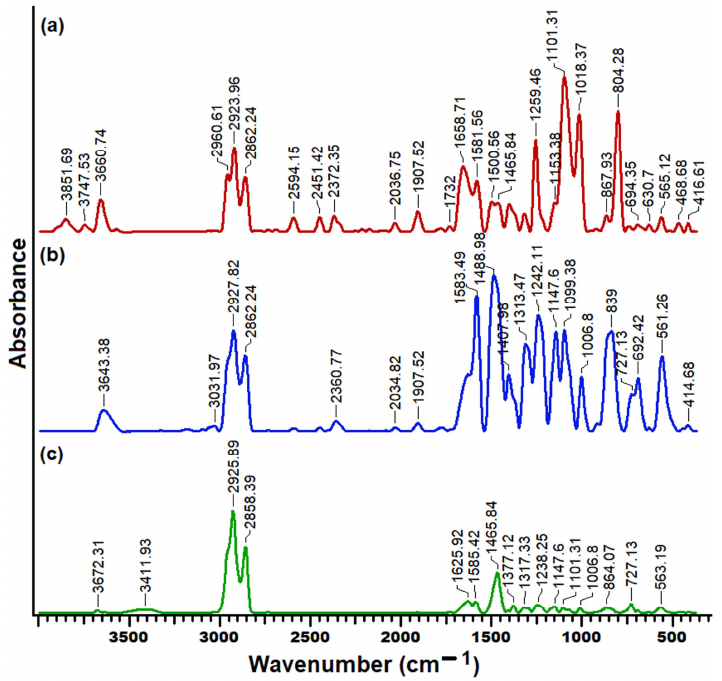
Figure 4. FTIR spectra recorded from membranes obtained from casting solutions: ( a ) PSFQ (P0), ( b ) PSFQ/Cyphos 101 IL (PIM-Ph 5 wt%), and ( c ) PSFQ/Aliquat 336 (PIM-Am 15 wt%).